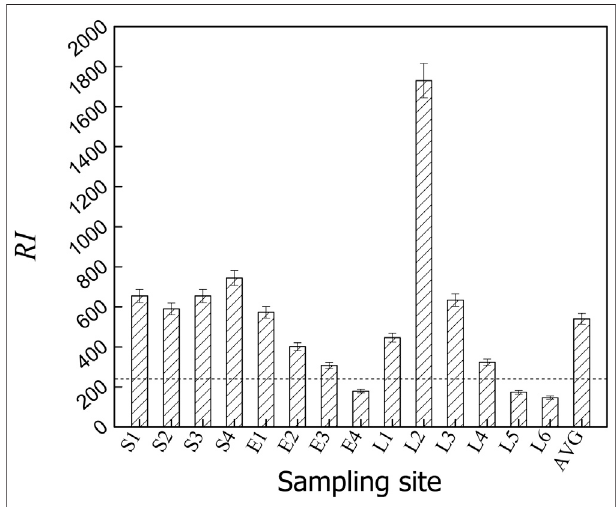
FIGURE 5 | Spatial changes of the heavy-metal RI in